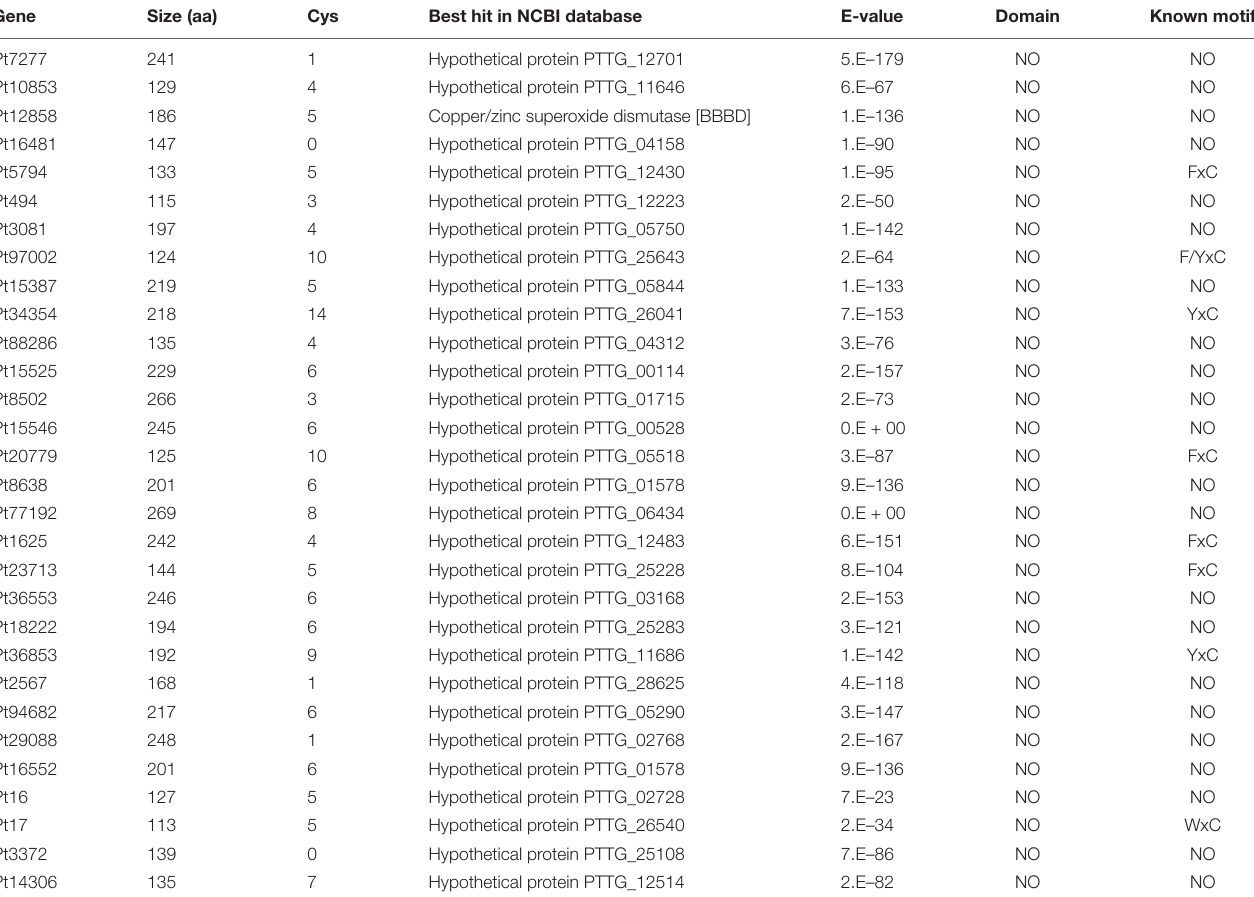
TABLE 3 | Sequence characteristics of the 30 candidate